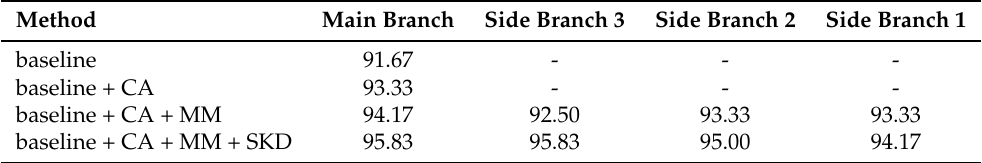
Table 3. Ablation experiments performed on Messidor dataset according to the accuracy metric (unit: %).